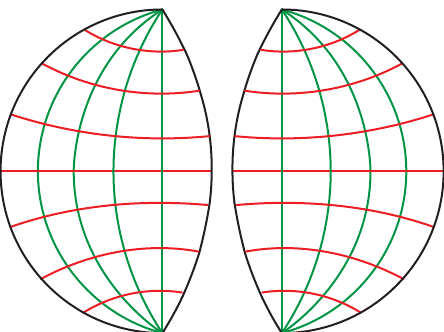
Figure 1. Constant time slices of the two AdS patches on the two sides of the defect, corresponding to the metric (2.4), glued together at the location of the defect along y = constant r are indicated in red and lines of constant y are indicated in